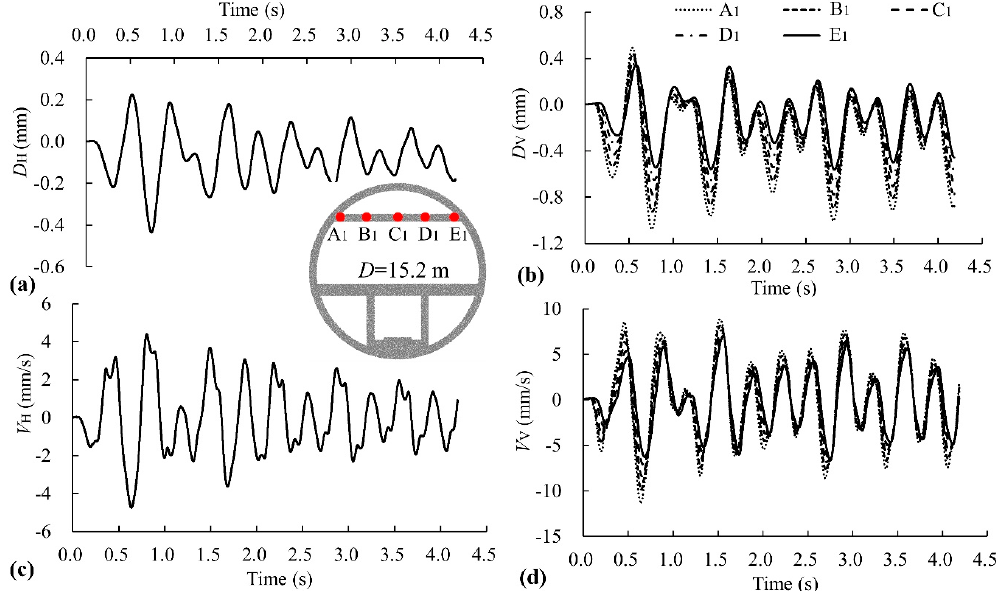
Figure 8. Displacement and velocity of five measurement points (A 1 , B 1 , C 1 , D 1 and E 1 ) in Wall_1 of T2: ( a ) D H ; ( b ) D V ; ( c ) V H ; ( d ) V V.